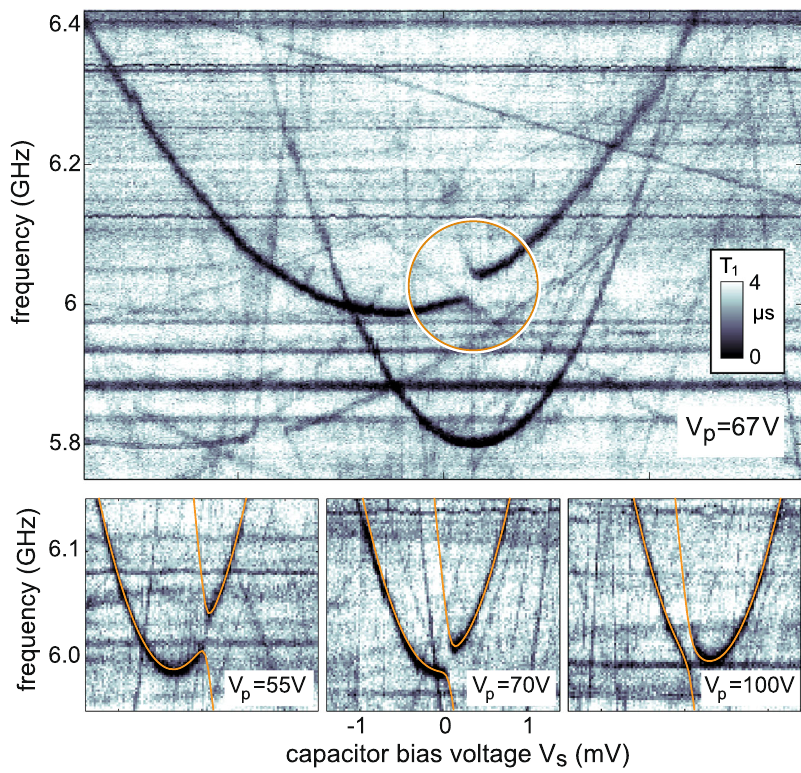
Fig. 3 Interacting TLS in the sample dielectric. Top : Avoided level crossing (encircled) in the spectrum of a TLS due to coherent interaction with a second TLS. Bottom : The observed level splitting could be shifted through the TLS symmetry point by mutually detuning the two TLS via the physical strain. Each fi gure was recorded for the same range of bias voltages but at different voltage V p applied at the piezo actuator. Superimposed orange lines show the transition frequencies calculated using independently measured TLS parameters and best- fi tting interaction